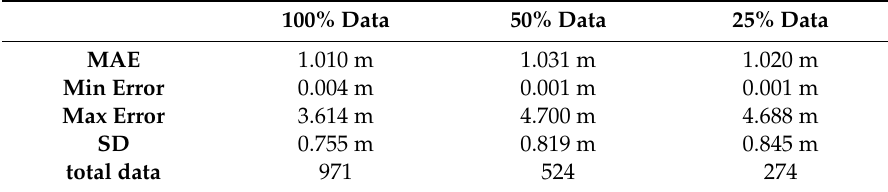
Table 7. Accuracy assessment of estimated data using 100%, 50%, and 25% data of field peat depth.